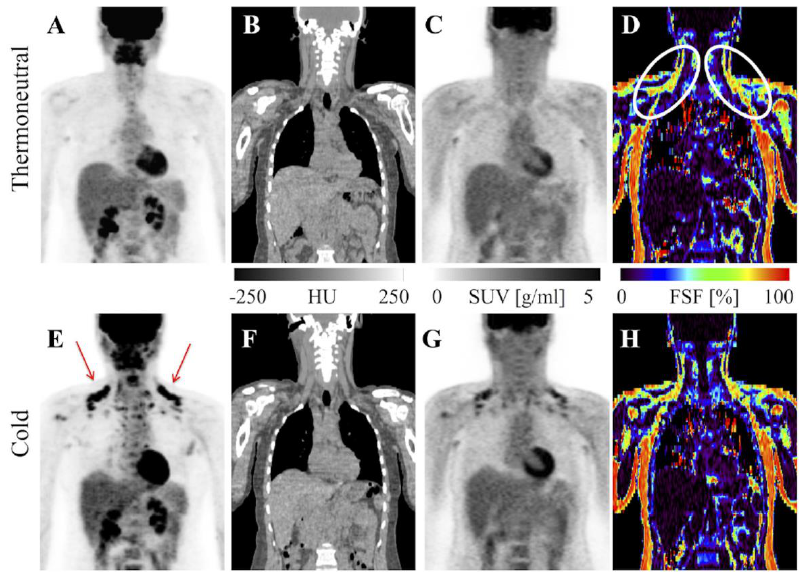
Figure 3. MRI vs. FDG-PET/CT in detection of BAT. FDG-PET/CT and MRI of a healthy BAT-positive research subject. FDG uptake is visible in supraclavicular BAT with cold exposure on the PET maximum intensity projection (MIP; E, red arrows) and absent from the thermoneutral PET MIP (A). CT shows adipose tissue in the same region (B and F) and PET shows increased standardized uptake value there after exposure to cold (C and G). MRI-derived fat signal fraction from the same subject shows adipose tissue with relatively low levels of fat (white ovals) in the same region at thermoneutral and cold conditions (D and H). Image reproduced with permission from reference 41.